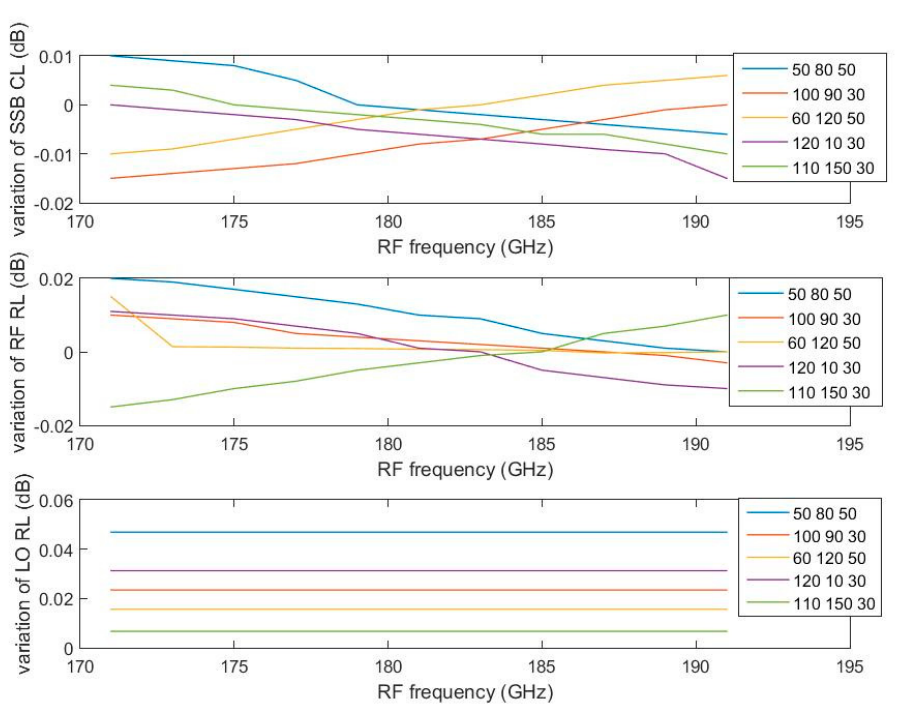
Figure 9. Effects of random conductive adhesive on mixer 1.